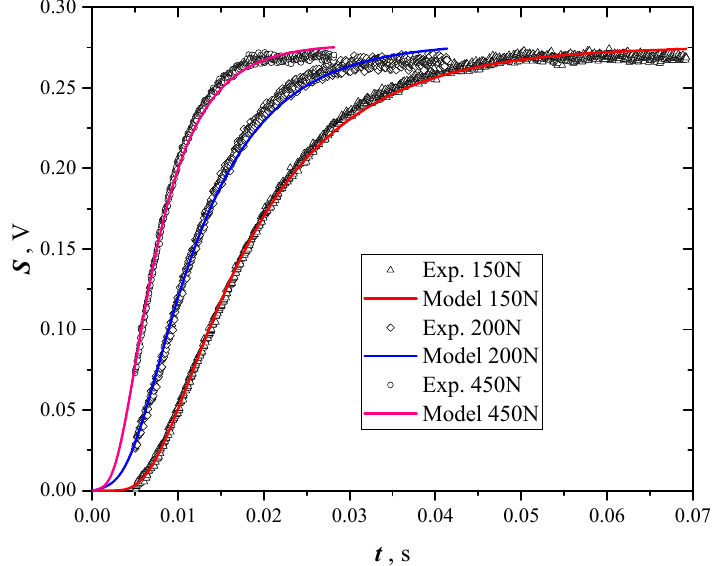
Figure 4. Signal recorded for three different samples of GNP not coated, pressed with different loads (100, 200 and 450 N).